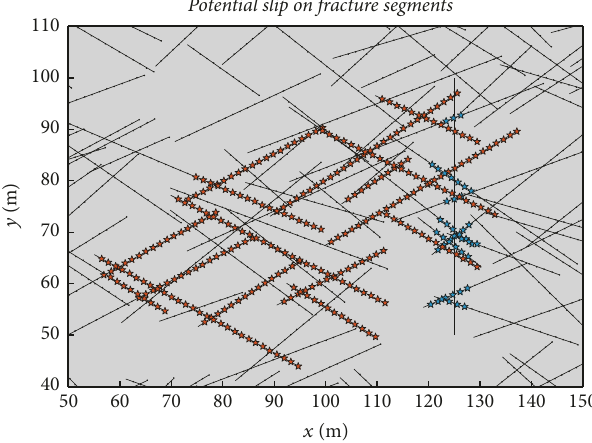
Figure 16: Potentially slipping fracture segments after 30 days of injection into the fracture network. The two colors indicate the mechanism of failure. Red: fracture segments failing due to fluid pressure alone. Blue: failure due to the combined effects of fluid pressure and thermal stress.